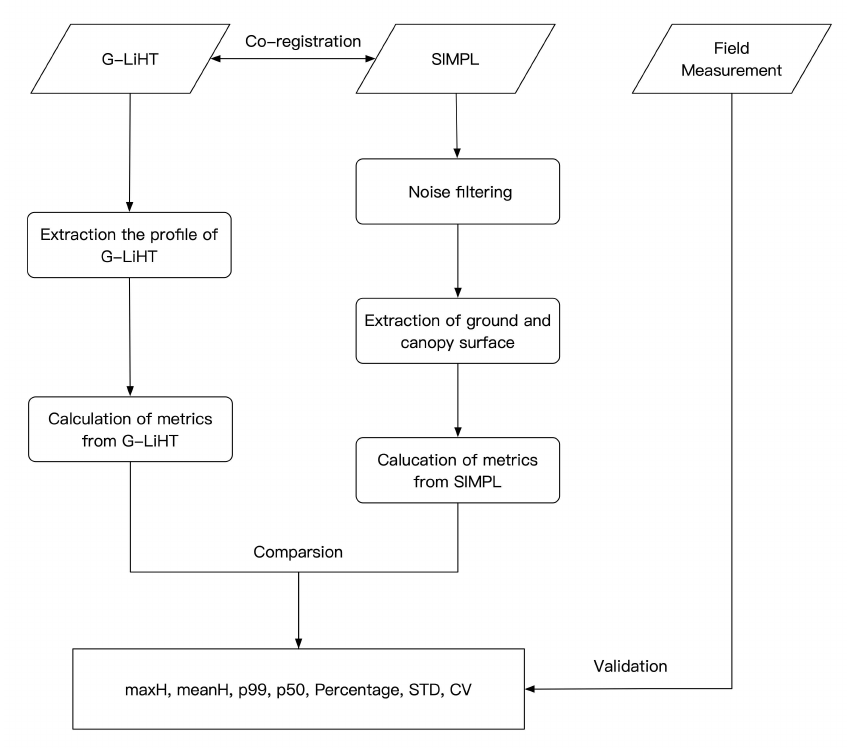
Figure 4. The flowchart of the proposed method used in this